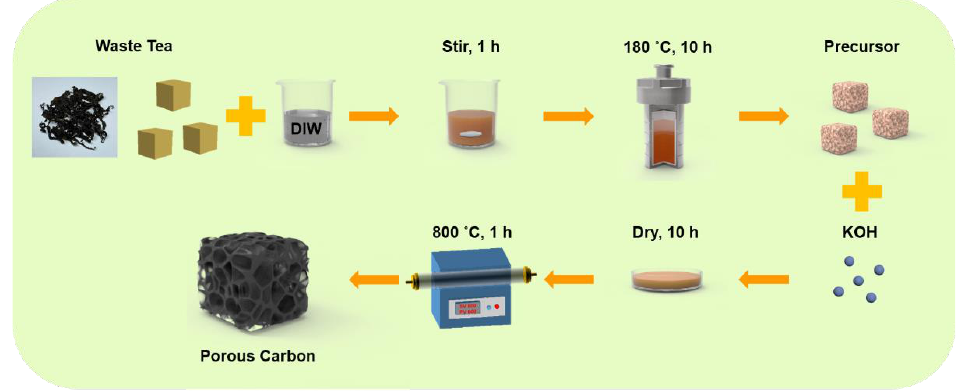
Figure 1. Schematic of the sequential preparation process of the tea-waste-based activated carbon Figure 1. materials.